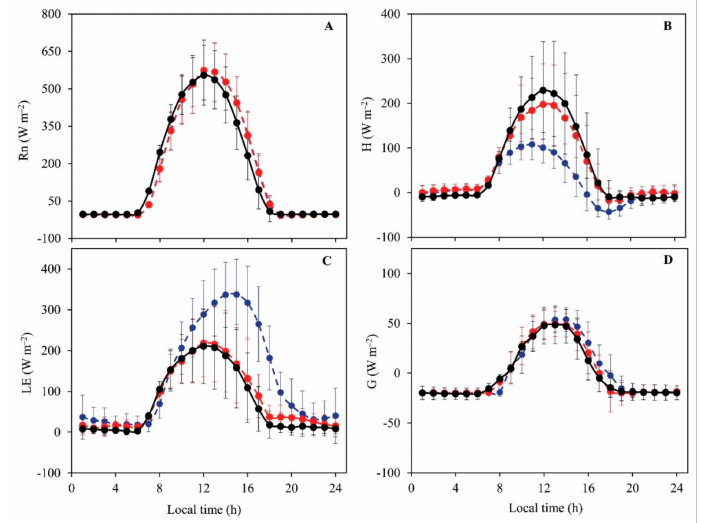
Figure 3. Simulations without calibration (dashed blue lines), simulations with calibration (dashed red lines, simulation V) and eddy covariance observations (solid black lines) of mean daily cycle of energy fluxes during the wet season of 2014. Net radiation (Rn; ( A )), sensible heat flux (H; ( B )), latent heat flux (LE; ( C )) and soil heat flux (G, ( D )). Vertical bars indicate the standard deviation of fluxes. For details on the calibrated parameters of simulation V, see Table 2.